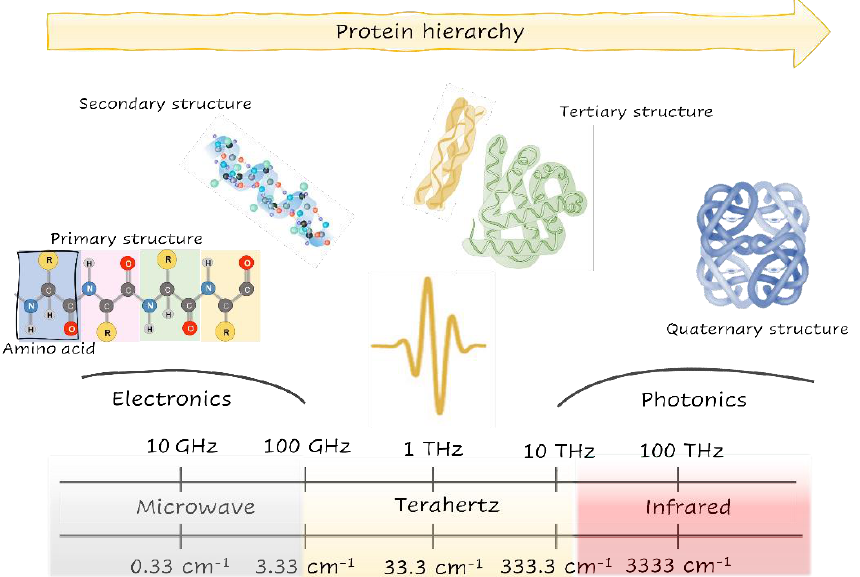
Figure 1. THz region and applications in the protein field of THz radiation. The THz domain typically lies between microwave and infrared regions, which refers to the frequency band spanning 0.1–15 THz (from 3 cm − 1 to 500 cm − 1 ). The generation of THz radiation was successfully developed with both electronics and photonics, including the up-conversion of electronic radiofrequency sources and the down-conversion of optical sources. THz technology detects proteins, illustrated by their structure hierarchy.